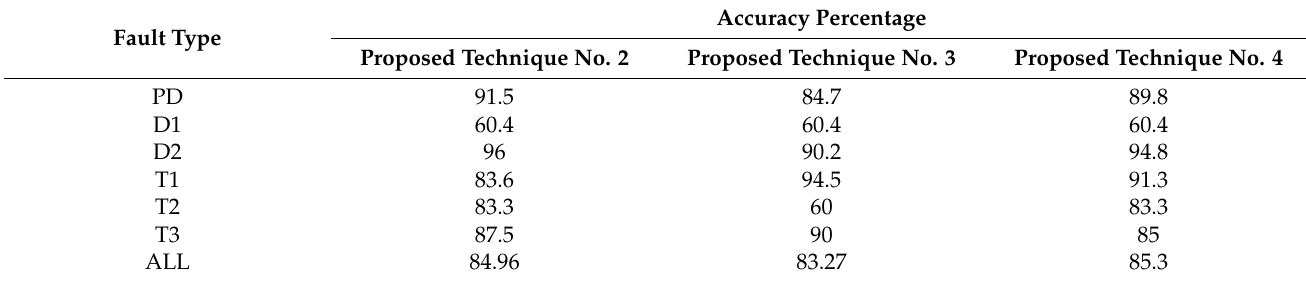
Figure 7. Comparison between the proposed techniques of no. 2 and no. 3. Table 5. Accuracy percentages of no. 2, no. 3, and no. 4 techniques.